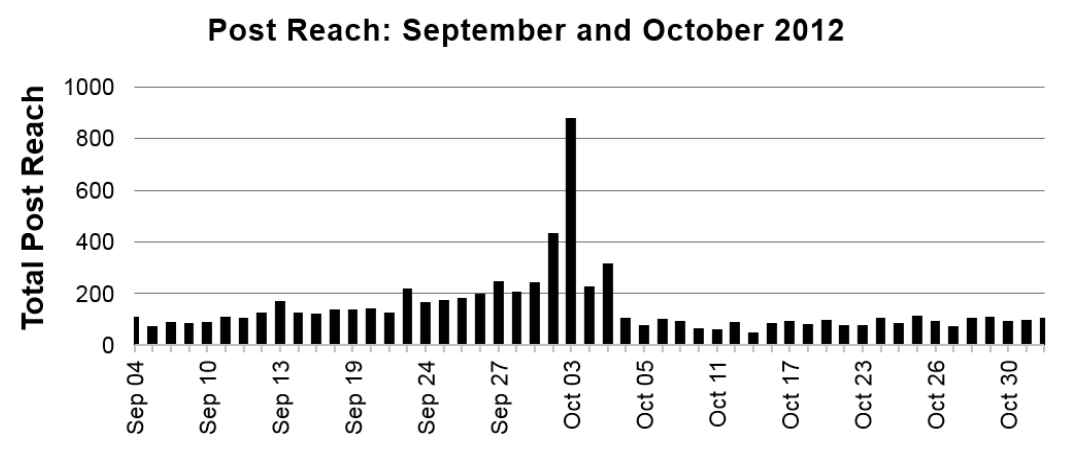
Daily Facebook Reach for the months of Banned Books Week and the banned books hoax